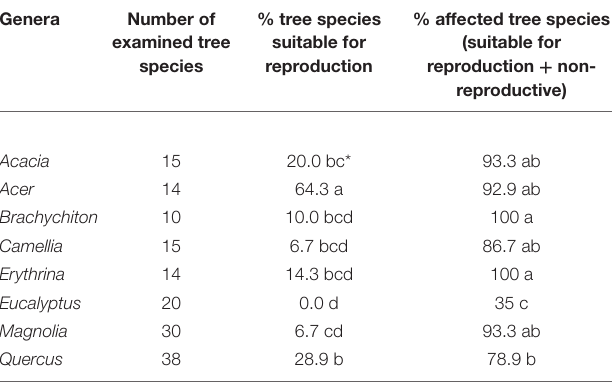
TABLE 7 | Comparison of occurrences of tree species suitable for reproduction and all attacked tree species in each of the eight examined botanical genera. Genera Number of examined tree